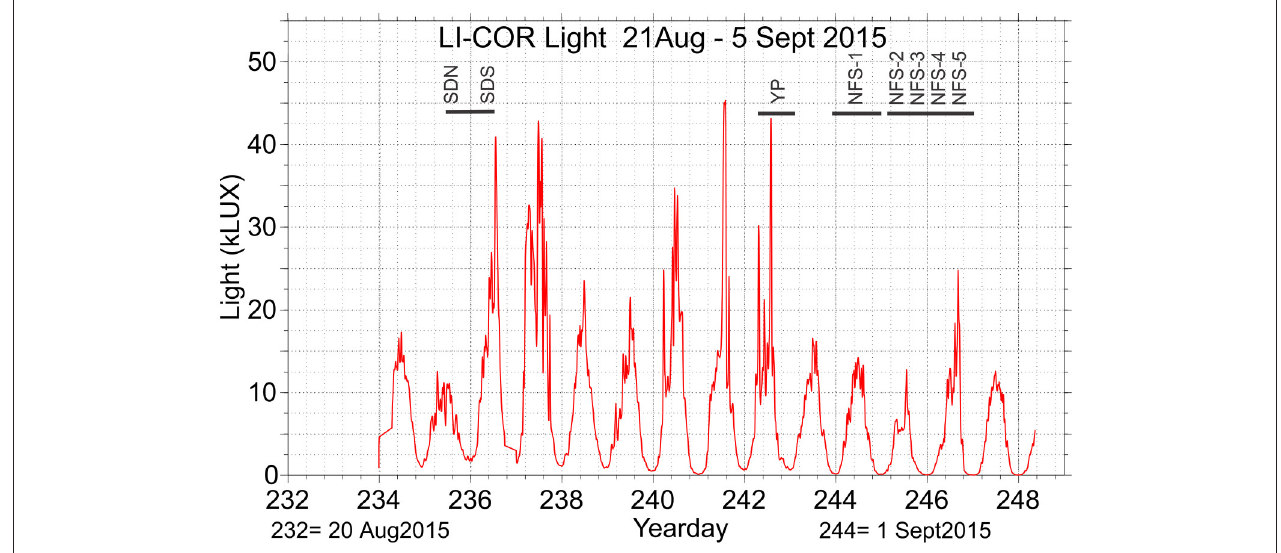
FIGURE 2 | Light levels determined from a LI-COR light data logger recorded during SI_ARCTIC 2015 survey. The eight named time periods where the diel vertical migration studies were conducted are indicated by the black lines above the light data [Sofia Deep N (SDN), Sofia Deep S (SDS), Yermak Plateau (YP), Northern Fram Strait 1 (NFS 1), Northern Fram Strait 2 (NFS 2), Northern Fram Strait 3 (NFS 3), Northern Fram Strait 4 (NFS 4), and Northern Fram Strait 5 (NFS